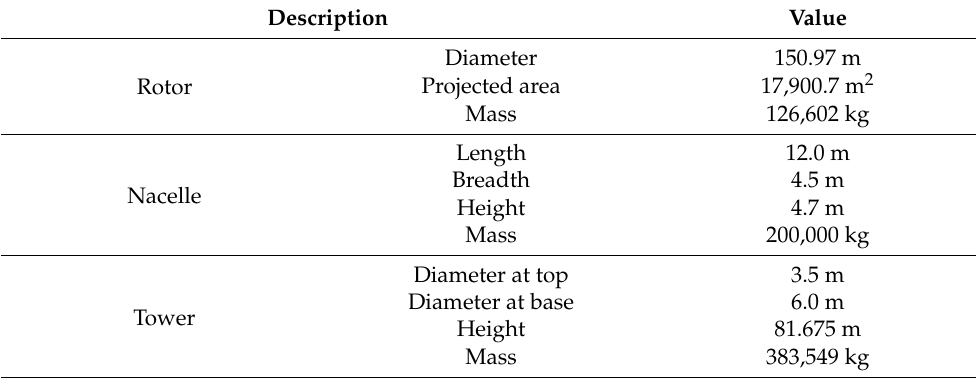
Table 2. Properties of 5 MW baseline wind turbine.